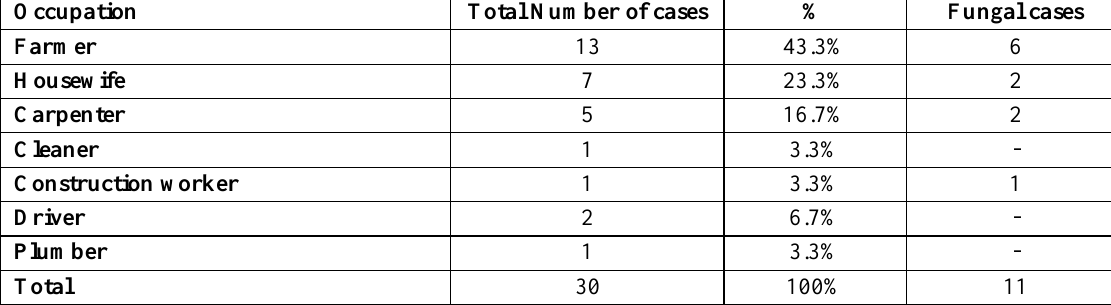
Table 1. Distribution of occupation among the studied group.